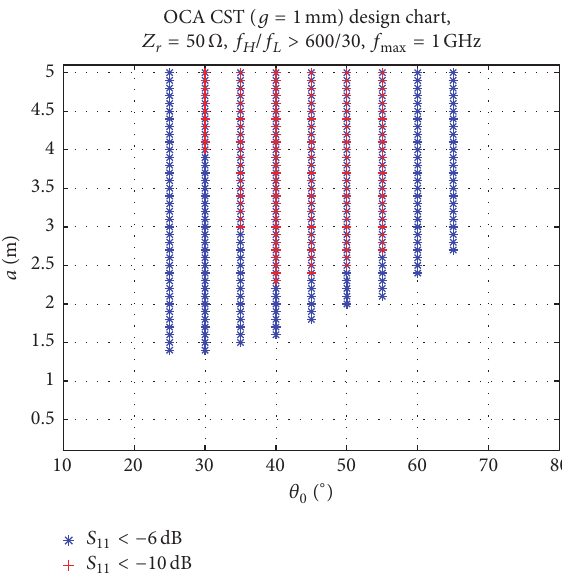
Figure 20: Design chart for the CST simulated OCA example with DF min = 20.